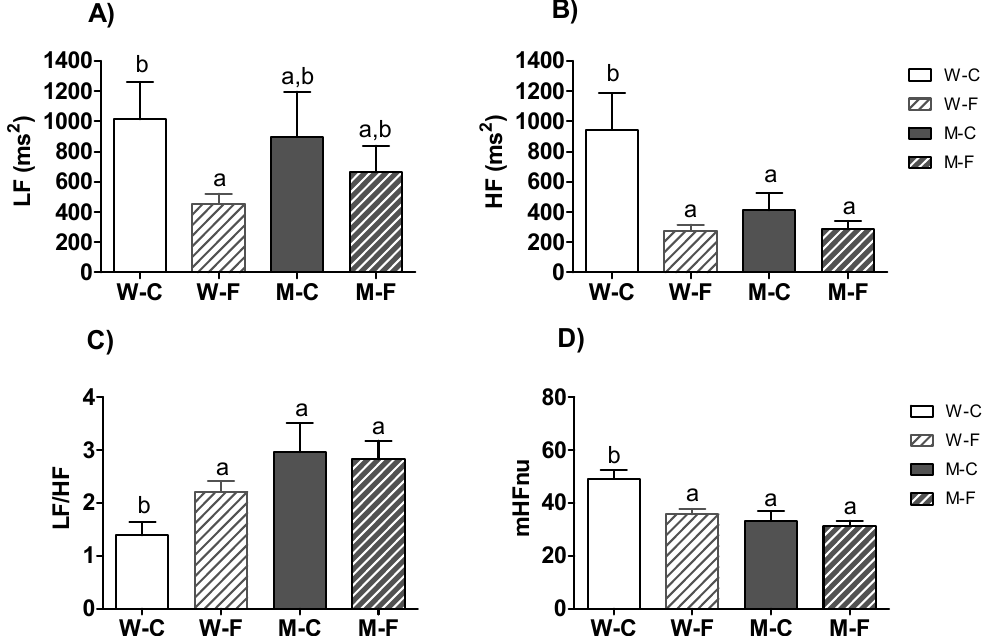
Figure 4. Comparison of the HRV frequency-domain indices in the sample. Mean ± SEM of ( A ) power of the low frequency band (LF), ( B ) power of the high frequency band (HF), ( C ) LF/HF ratio, and ( D ) normalized HF value (HFnu). a,b Mean values with unlike letters were significantly different between groups (two-way ANOVA and Duncan’s post hoc comparison, p < 0.05). W-C: Healthy control women ( n = 25); W-F: ME/CFS women ( n = 44); M-C: Healthy control men ( n = 18); M-F: ME/CFS men ( n =